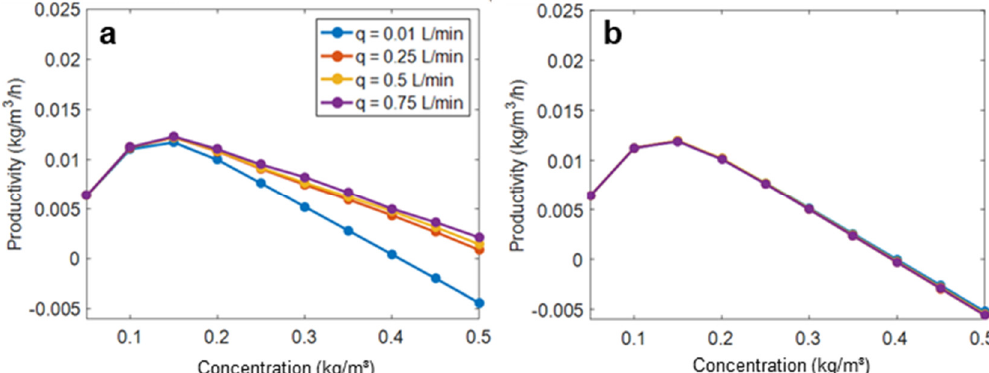
Figure 8. Biomass productivity in the Standard Design PBR at various microalgal concentrations and air flowrates, calculated using ( a ) the dynamic growth model with parameters k 21 = 0.1 s −1 , k 23 = 10 −4 m 2 /μE; and ( b ) the steady state growth model.